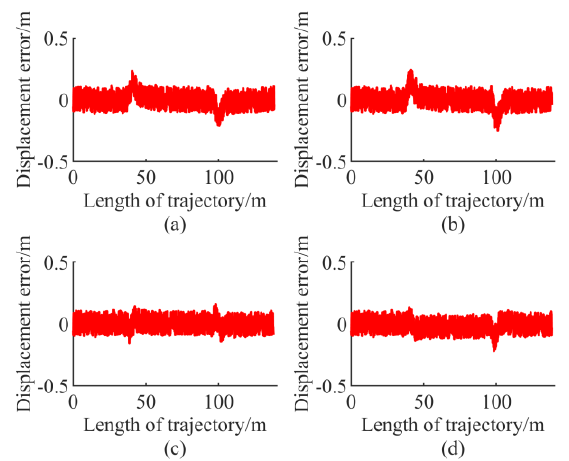
Figure 30. The displacement error with the positioning error in ±0.1m. ( a ) LMPC. ( b ) LEMPC. ( c ) NMPC. ( d ) NEMPC.